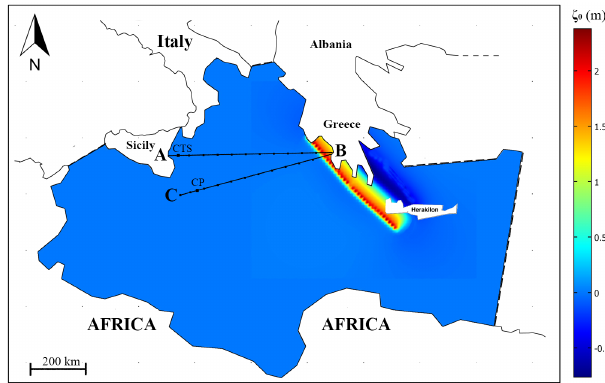
Figure 2. Residual vertical seabed dislocation, ζ 0 (m), for the AD 365 Crete earthquake as reconstructed by Tonini et al.